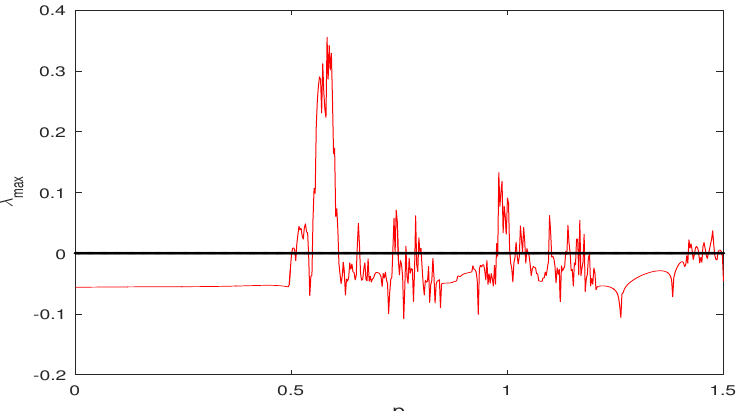
Figure 4. Maximum Lyapunov exponents versus P of D.T.H.N.N with incommensurate fractional V.O